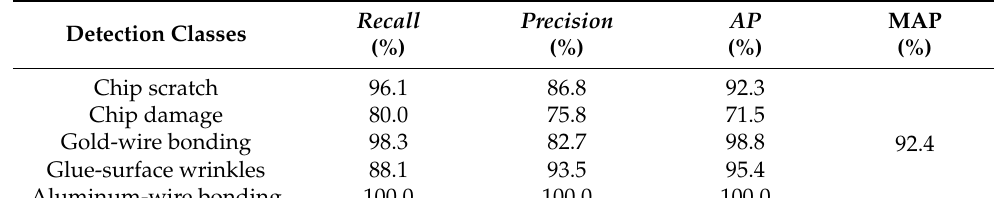
Table 2. Statistics of target-detection results with network optimization.